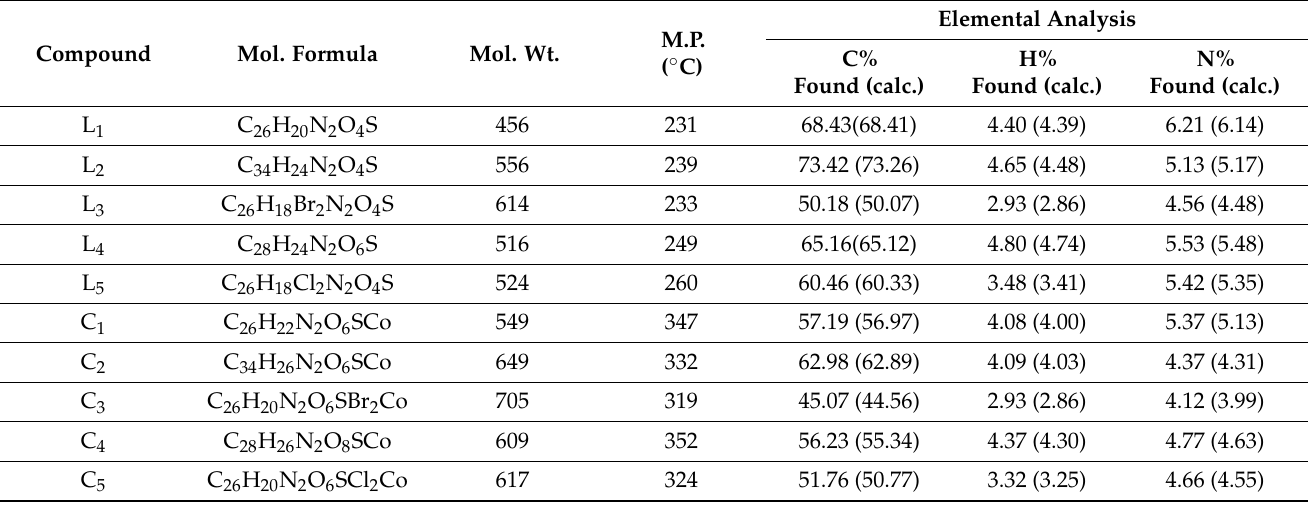
Table 1. Elemental analysis data of Schiff base ligands and their Co(II) complexes.